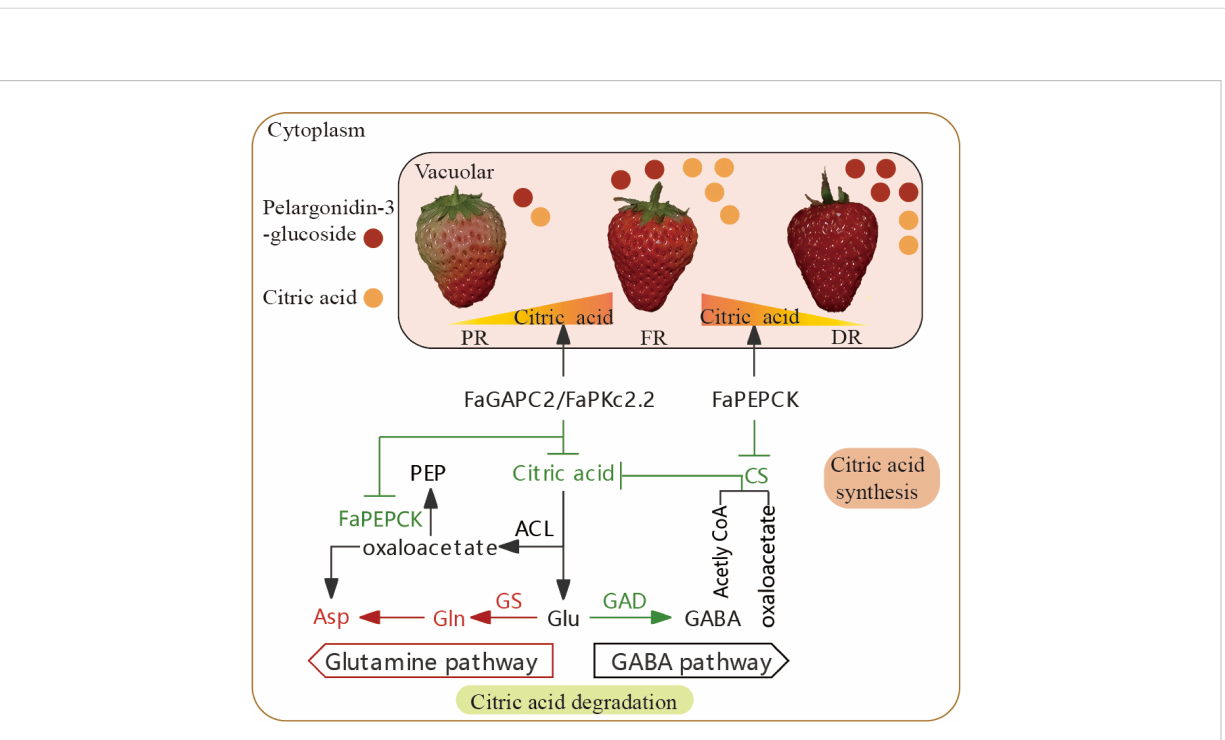
FIGURE 8 Potential mechanism of citric acid degradation during strawberry fruit development. Red and green letters or lines represent upregulated and downregulated metabolites or enzymatic activities. The yellow-orange triangle represents the change in citric acid content during strawberry fruit development. The red and orange circle represent the content of pelargonidin 3-glucoside and citric acid in strawberry fruit, respectively. CS, citrate synthase; ACL, ATP-citrate lyase activity; GS, glutamine synthetase; GAD, glutamic acid decarboxylase; Glu, Glutamate; Gln, glutamine; Asp, asparagine; GABA, gamma-aminobutyricacid; PR, partial red; FR, full red stage; DR, dark red